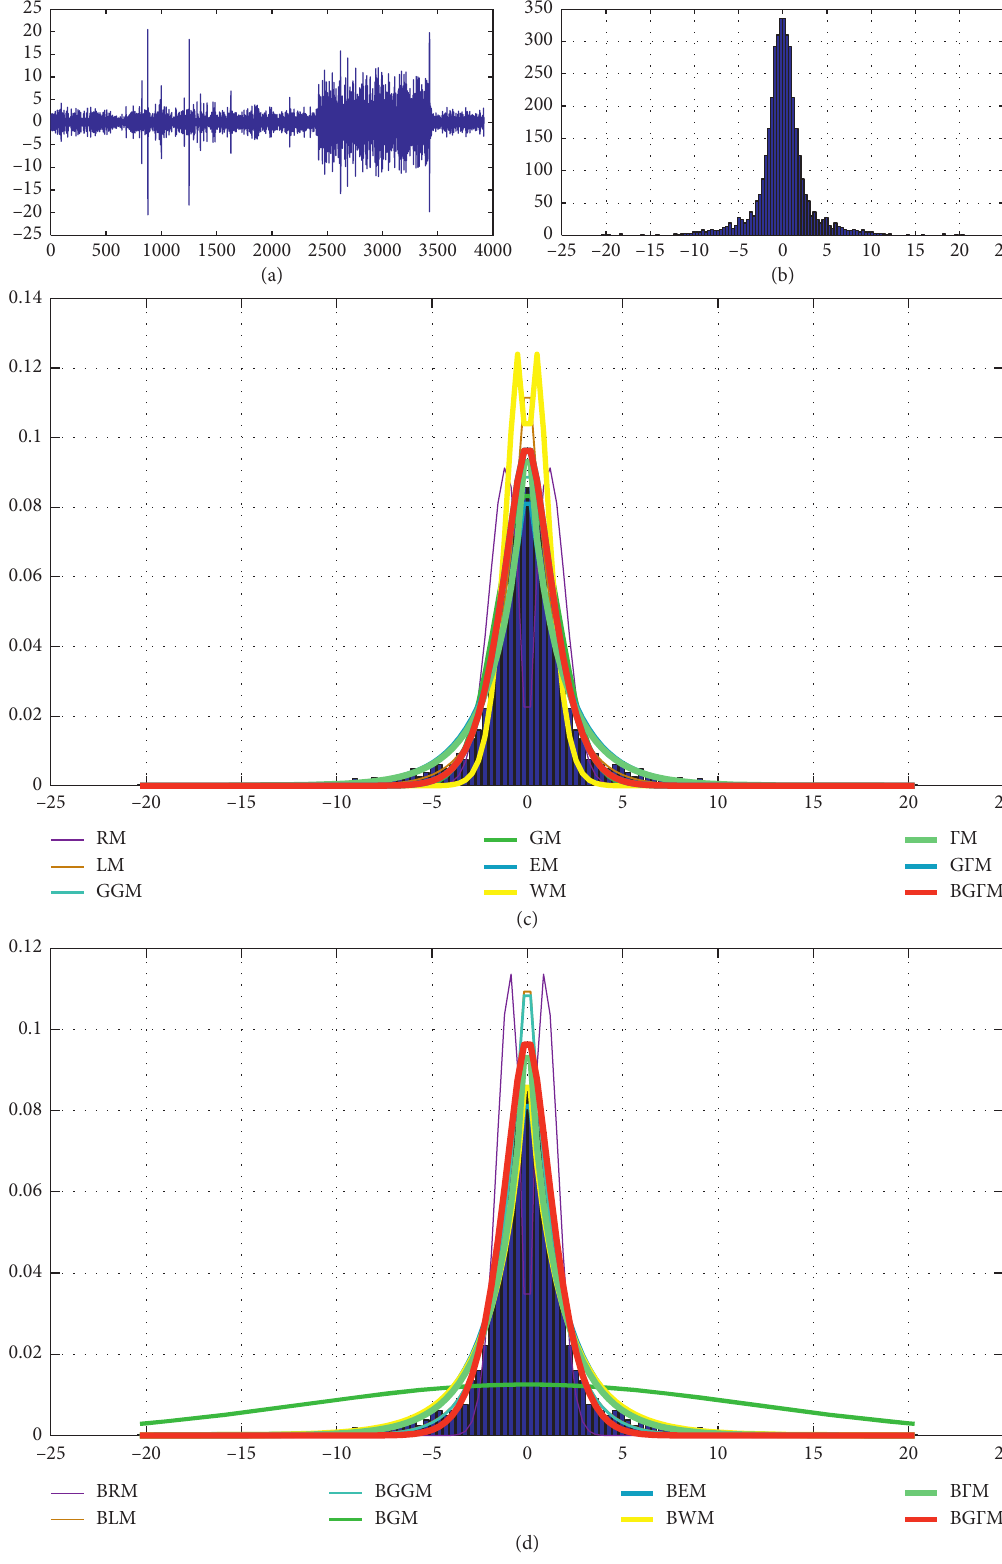
Figure 11: Approximation of the wavelet coefficients. (a) “Leleccum.wav”(leleccum (1 :3920)); (b) approximation of the wavelet coefficient (db1, CD, level 1) of “leleccum.wav;” (c) the estimated histogram of RM, LM, WM, GM, EM, GGM, Γ M, G Γ M, and G Γ M; (d) the estimated histogram of BRM, BLM, BWM, BGM, BEM, BGGM, B Γ M, and BG Γ